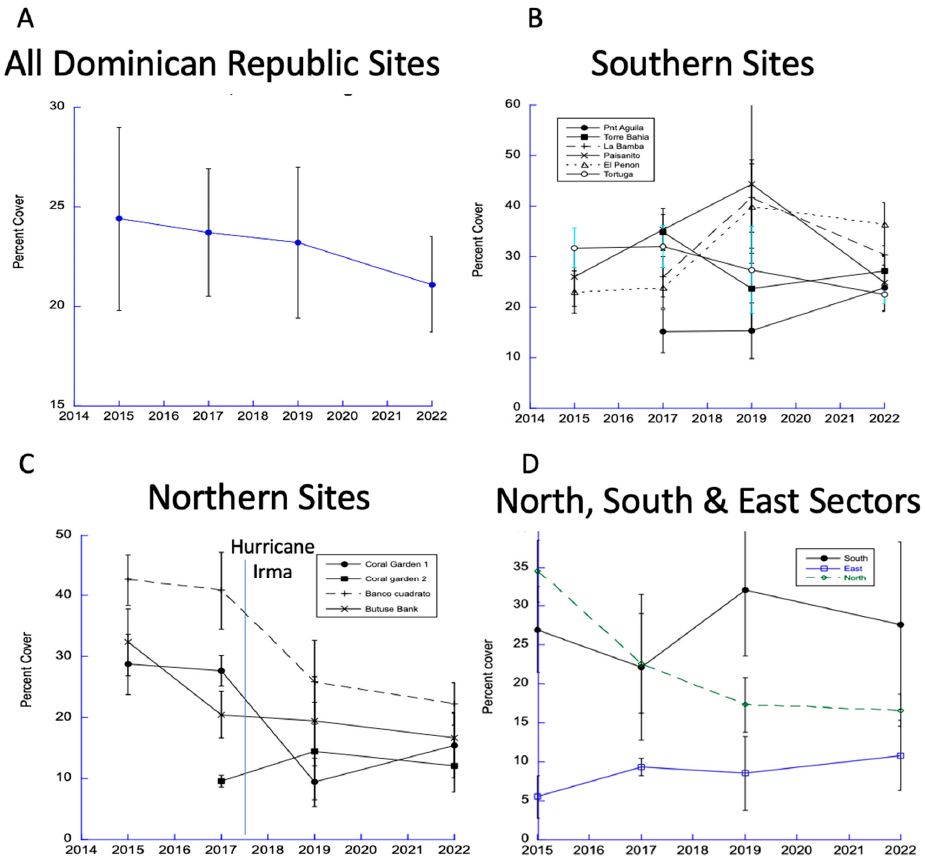
Figure 2. Trends in coral cover from all DR sites ( A ), in the south ( B ), and in the north ( C ). Data from North, South, and East Sectors show strong and protracted declines in coral cover in the North Sec- tor ( D ). Sector ( D